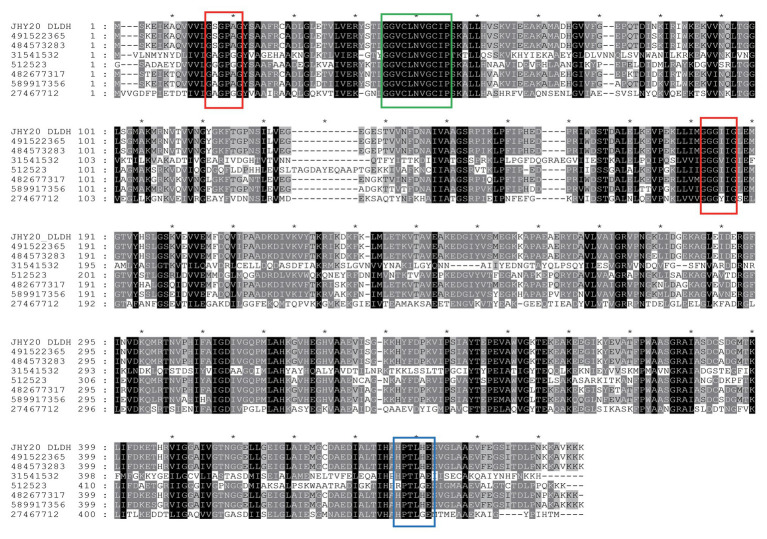
A multiple sequence alignment of Vibrio parahaemolyticus strain JHY20 dihydrolipoamide dehydrogenase (DLDH) and a selected set of bacterial DLDH proteins. Numbers above the alignments indicate relative positions of the entirely aligned sequences. Identical amino acid residues, as well as the conserved ones (>50% of the sequences), are highlighted in black and in gray, respectively. The FAD and pyridine nucleotide-binding motifs (GXGXXG) are in red box. Two catalytic cysteine residues (GGXCXXXGCXP) and His-Glu pair residues (HXXXXE) are indicated by a green box and blue box, respectively. The DLDH sequences chosen for the analysis are obtained from GenBank and NCBI databases: GI: 491522365: Vibrio harveyi; GI: 484573283: Vibrio alginolyticus; GI: 31541532: Mycoplasma gallisepticum str. R(low); GI: 512523: N. meningitides serogroup B; GI: 482677317: Escherichia coli; GI: 589917356: Aeromonas caviae; GI: 27467712: Staphylococcus epidermidis ATCC12228. JHY20_DLDH, obtained in this study.